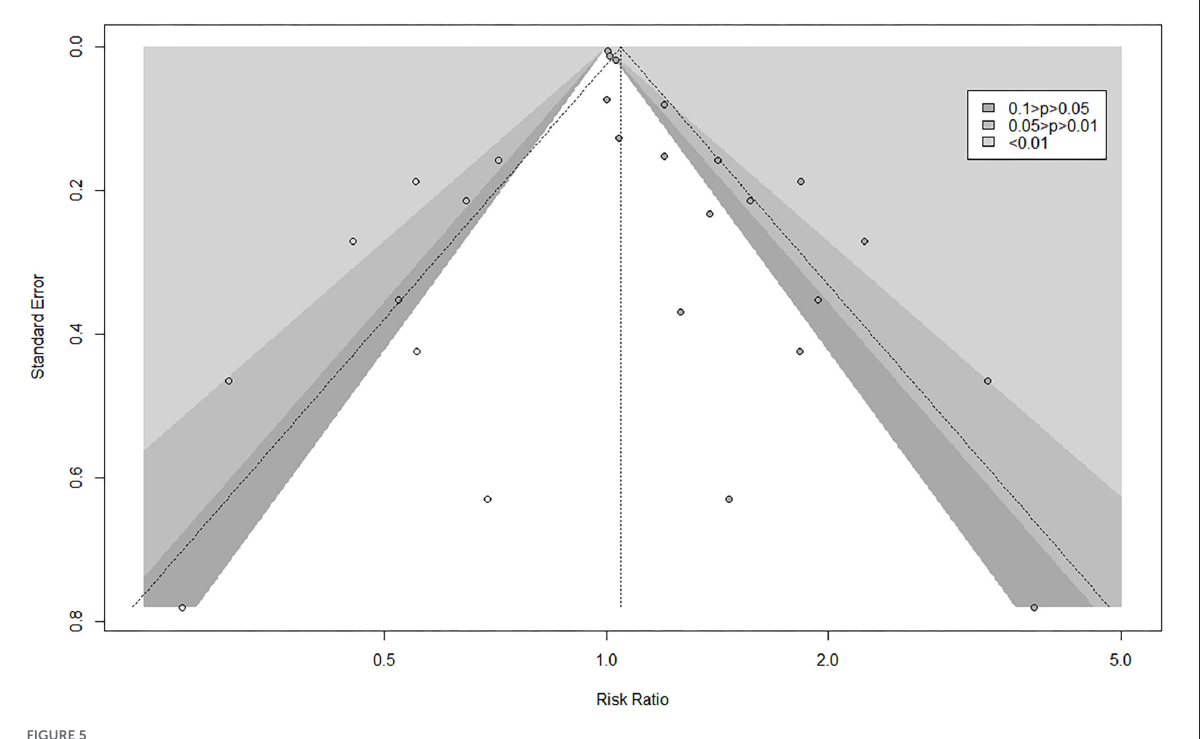
FIGURE5 Publication bias by